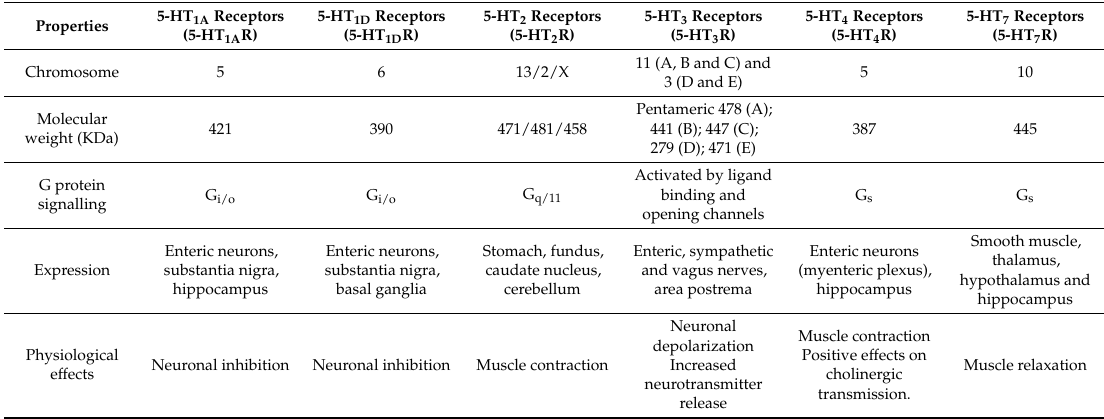
Table 3. Molecular and functional properties of the best-known human 5-HT receptor subtypes important for GIT functions.